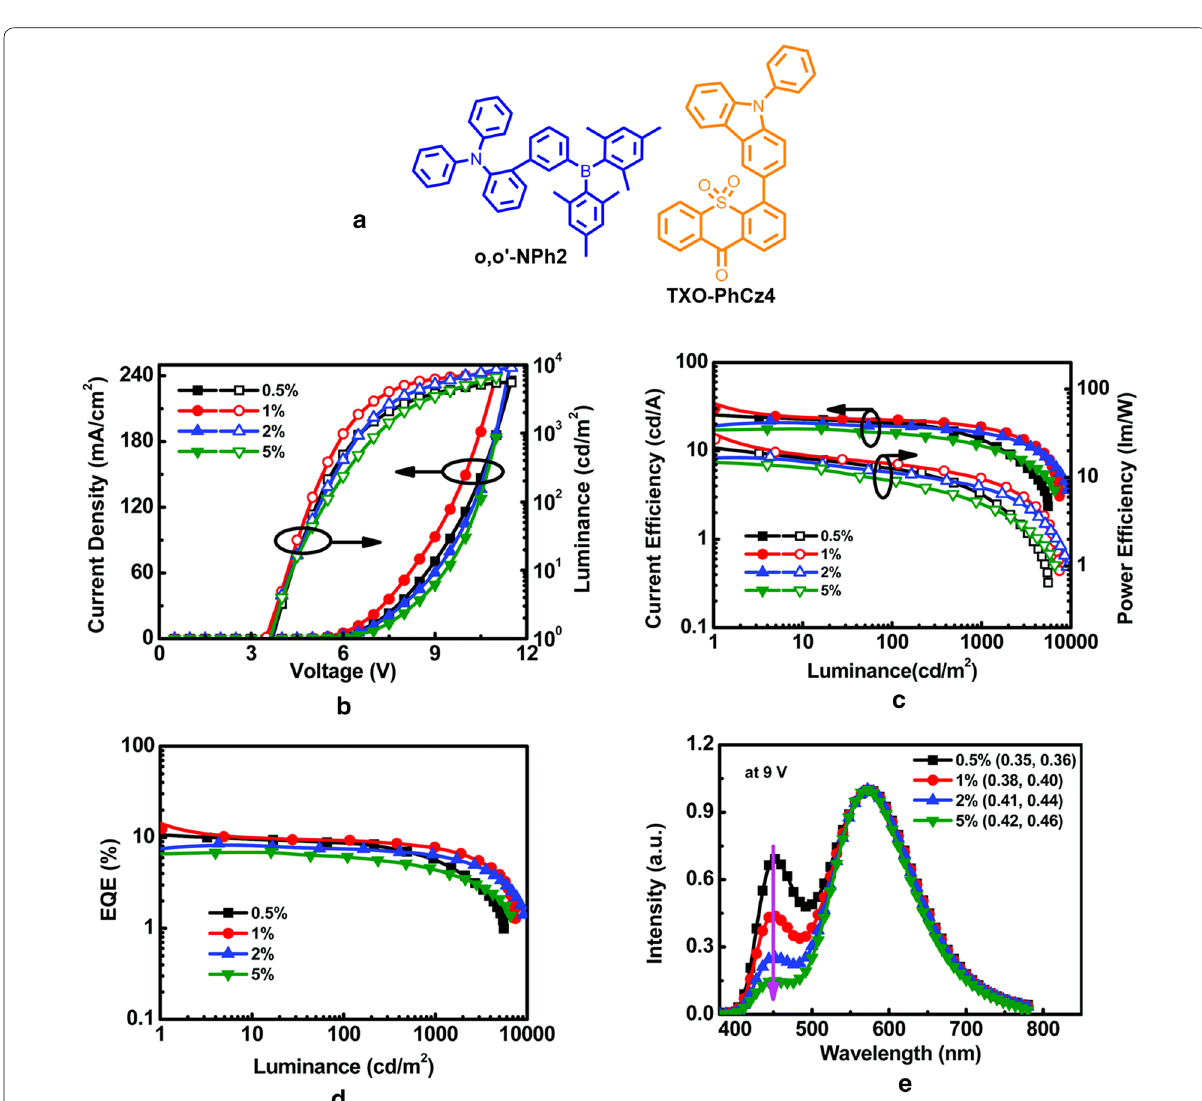
Fig. 19 a Molecular structures of the emitters. The EL characteristics of WOLEDs fabricated with different dopant concentrations of TXO-PhCz4, b current density–voltage–luminance curves, c current efficiency and power efficiency versus luminance curves, d EQE-luminance curves, e EL spectra of all devices at 9